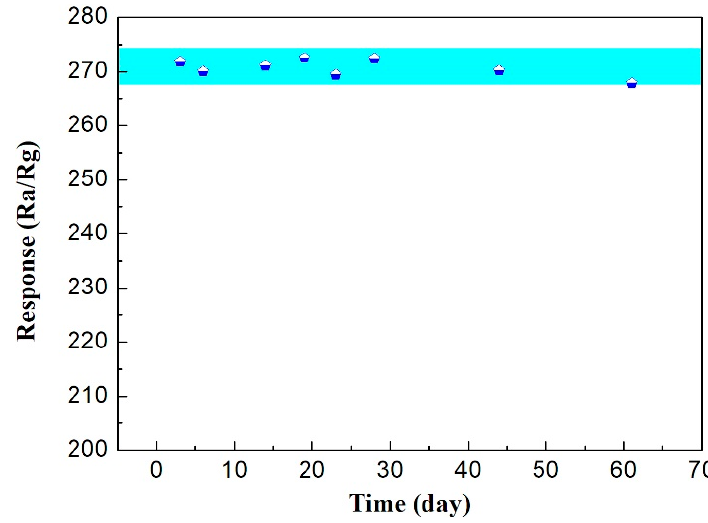
Figure 9. Response – recovery time curve of MgFe 2 O 4 /g-C 3 N 4 -10-based sensor to 500 ppm acetone at working temperature of 320 °C.